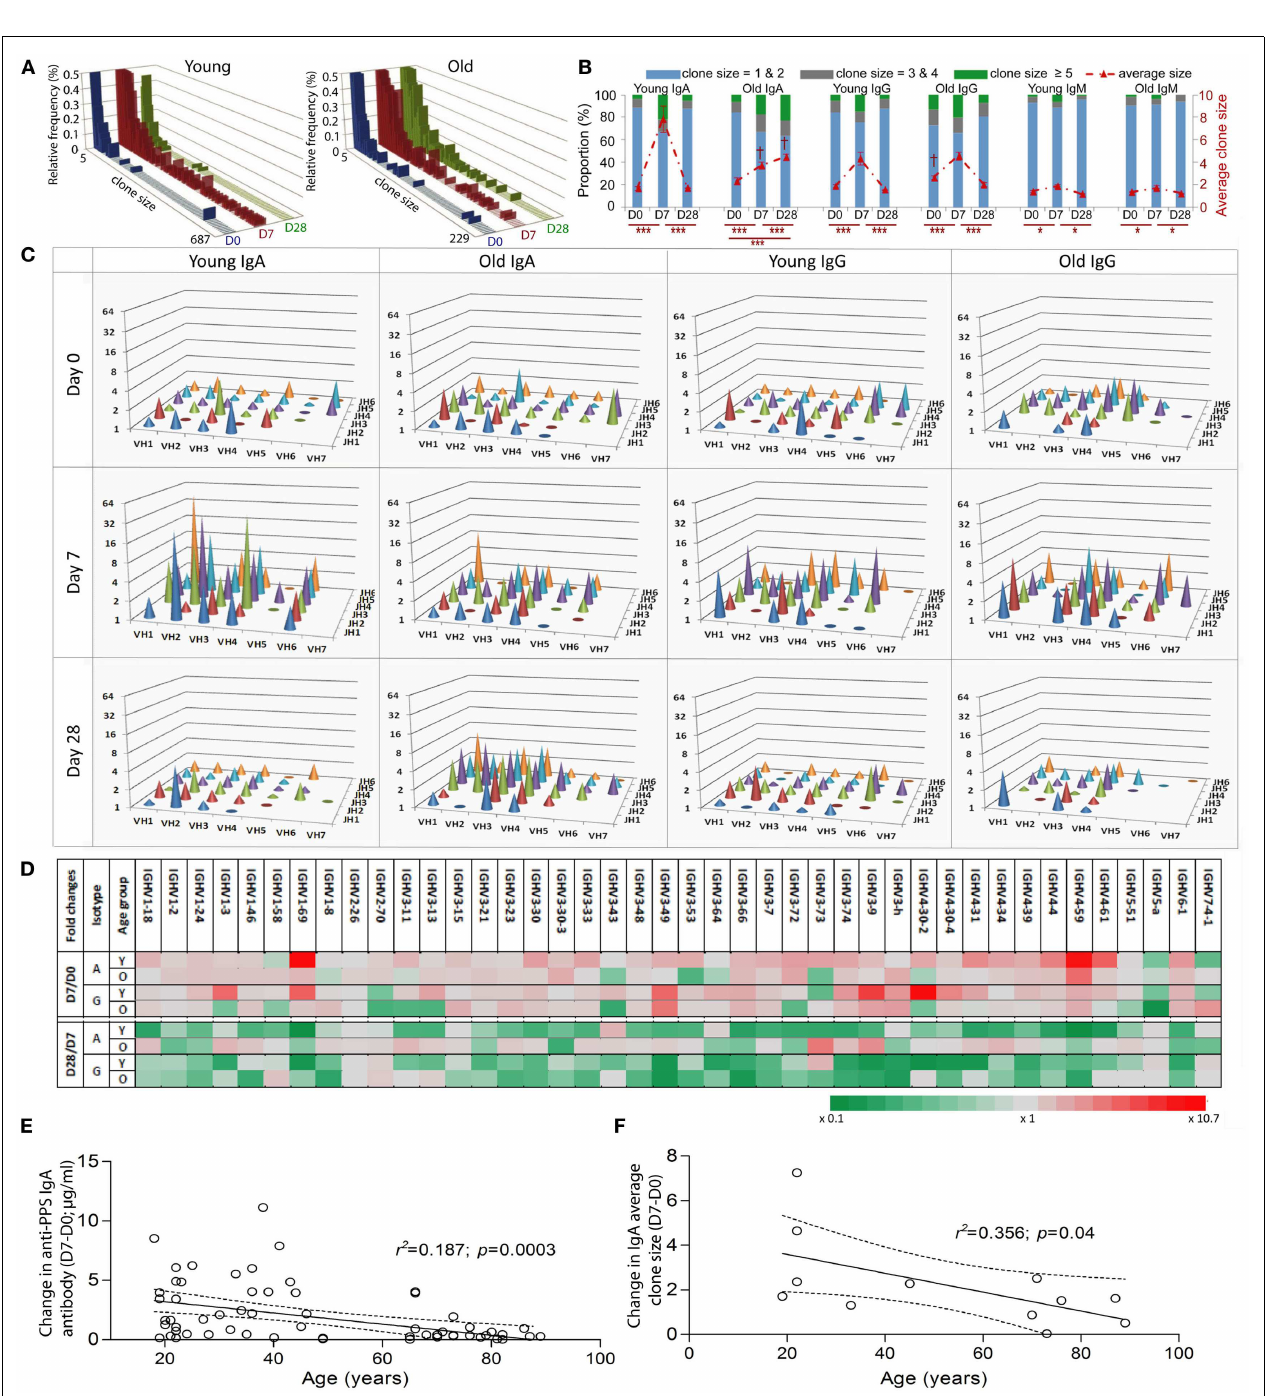
was calculated for each donor individually to be the ratio of total sequence numbers to total clonotype numbers, before being compared between different days (* p < 0.05 and *** p < 0.0005; repeated measures ANOVA comparison) or between ages ( † p < 0.005; one-way ANOVA comparisons). Bars indicate ± SEM. (C) IgA and IgG clonotypes from six young and six old donors at different days were grouped by IGHV family ( x -axis) and IGHJ ( z -axis) gene usage, and the average clone size ( y -axis) for each group was calculated. (D) IgA and IgG clonotypes from six young (Y)